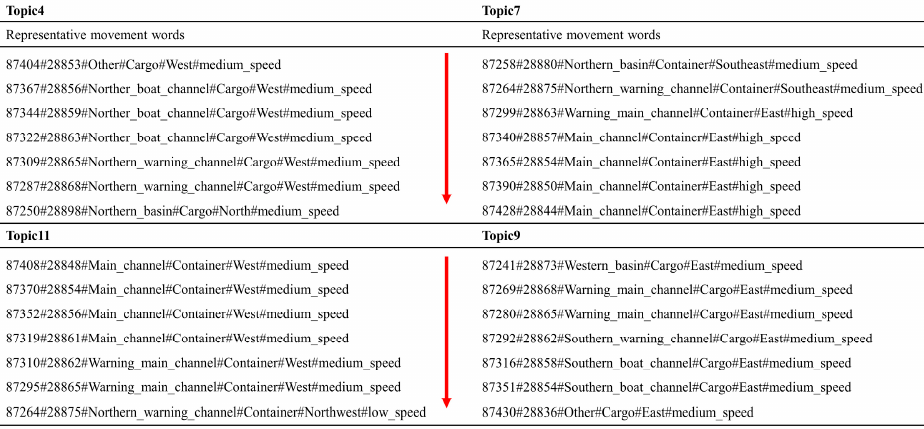
Figure 10. Representative motion words in the topic probability distribution.